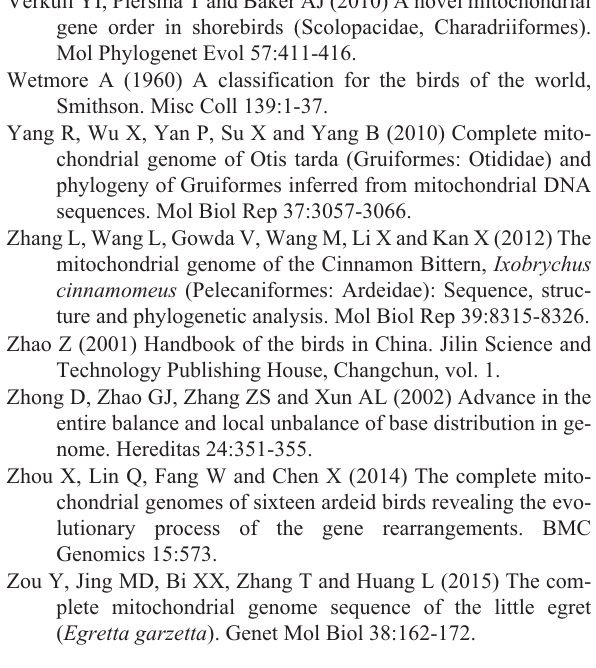
Table S1 - Species involved in phylogeny analyses of this study. Table S2 - Organization of mitogenomes of the A. atthis , H. smyrnensis and M. lugubris Table S3 - Genomic characteristics of 13 coraciiform mtDNA Table S4 - Sequences of conserved motifs in control regions of A. atthis , H. smyrnensis and M. lugubris Table S5 - Lengths and base compositions for protein coding genes in mitogenomes of A. atthis / H. smyrnensis / M. lugubris Table S6 Nucleotide compositions in three codon positions of 12 mitochondrial protein coding genes. Figure S1 - Structure diagram of control region (CR) in mitogenomes of A. atthis , H. smyrnensis and M. lugubris . Figure S2 - Secondary structures of the 22 tRNAs of three species. Figure S3 - Predicted secondary structures of MT-RNR1 in A. atthis . Figure S4 - Predicted secondary structures of MT-RNR2 in A. atthis . Figure S5 - Relative synonymous codon usage (RSCU) in the mitogenome of A. atthis , H. smyrnensis and M. lugubris . Figure S6 - Alignment of the mitochondrial MT-ND3 gene region spanning the extra base site (designated by *) for 13